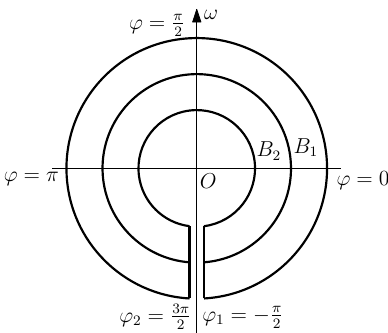
Figure 31: Rotating two-layer composite split ring.